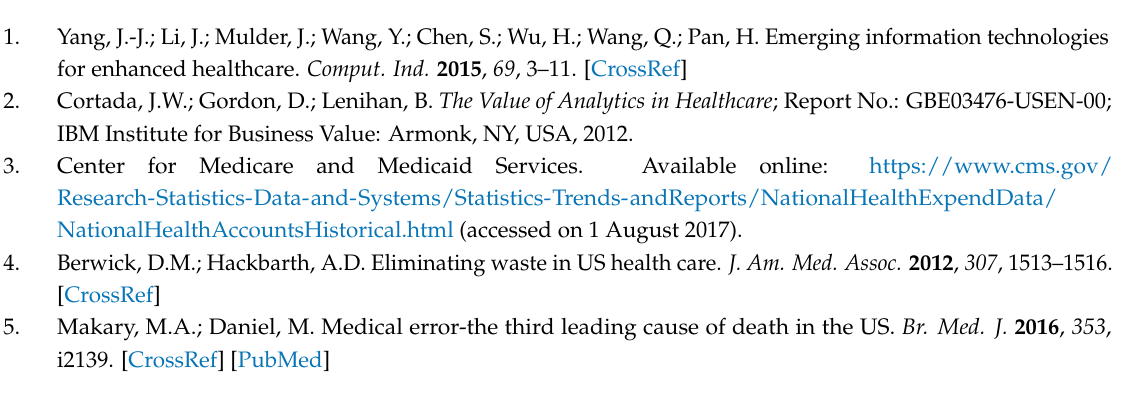
Table S1: PRISMA checklist, Table S2: Modified checklists and comparison, Table S3: Study characteristics, Table S4: Classification of reviewed papers by analytics type, application area, data type, and data mining techniques. Author Contributions: Contribution of the authors can be summarized in following manner.